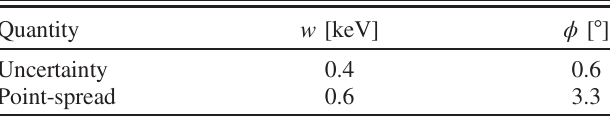
TABLE V. Values for rms point-spread function and 1 σ error bars.